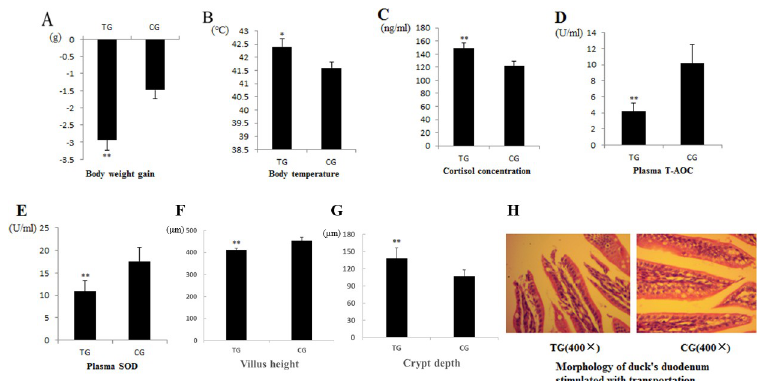
Fig 1. Effects of transport treatment. Comparisons of the (A) body weight, (B) body temperature, (C) plasma CORT concentration, (D) plasma T-AOC concentration, (E) plasma SOD concentration, (F) villus height, (G) crypt depth and (H) histological observations (400 × ) of the intestine between the transported and control ducks. � indicates P < 0.05, �� indicates P < 0.01.